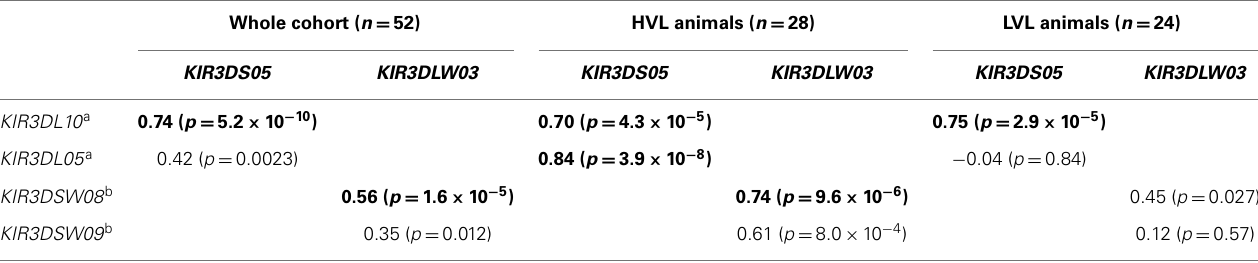
Table 2 | Correlation of KIR transcript presence at pre-infection